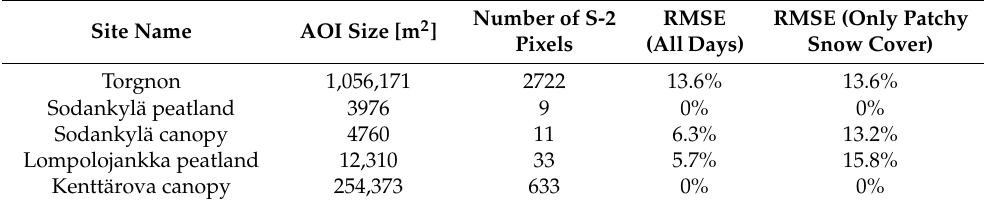
Table 7. AOI Sizes, corresponding number of S-2 pixels and subjective error of webcam data